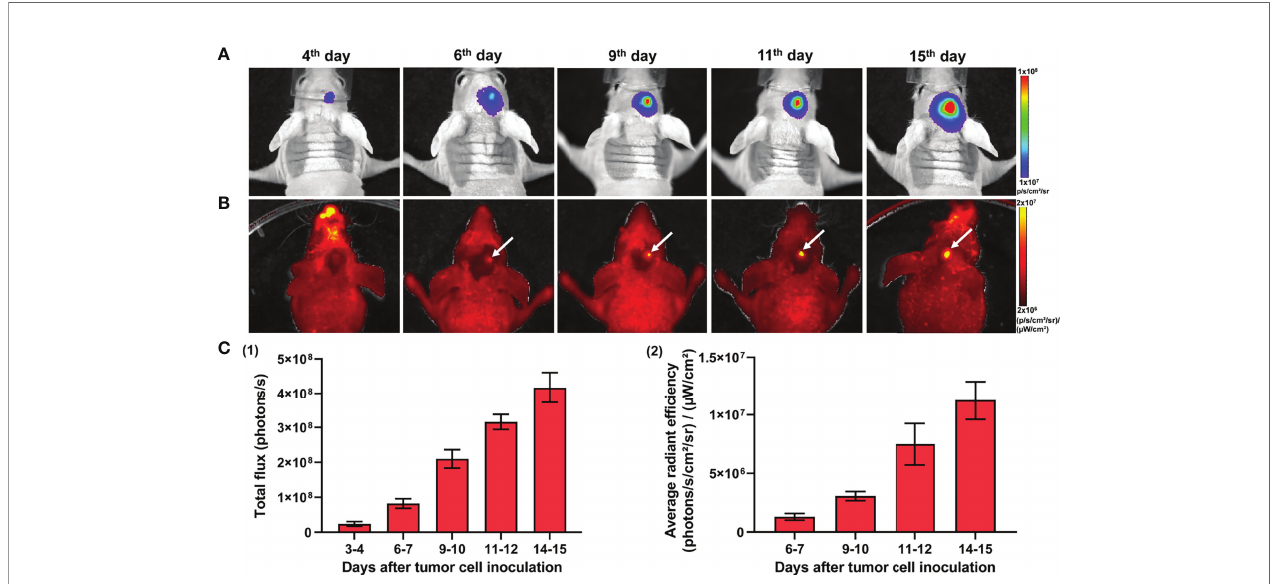
FIGURE 4 | In vivo bioluminescence and fl uorescence imaging of GBM7-Luc2-mKate2 xenografts. Representative bioluminescence (A) and fl uorescence (B) images of the tumor-bearing mice from the 4th to 15th days after tumor cell inoculation. (C) Quanti fi cation of the bioluminescence (1) and fl uorescence (2) signal during the tumor development. Mean ± SEM, n = 5 – 7